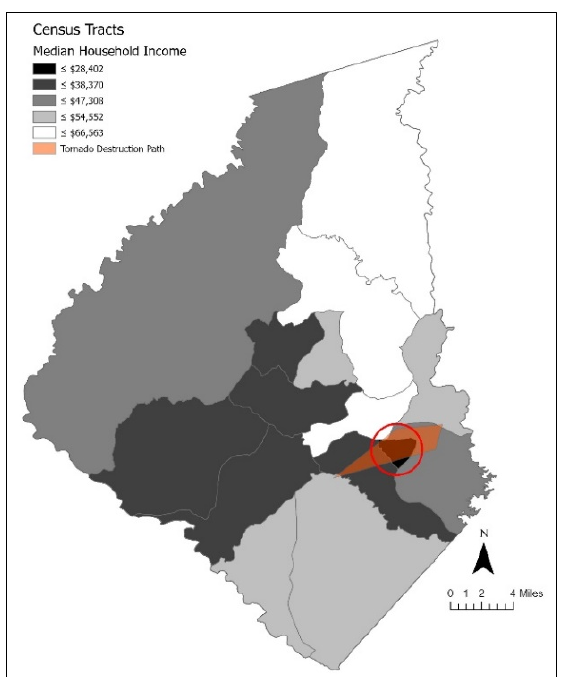
Figure 4. Median Household Income by Census Tract Figure 5. Life Expectancy by Census